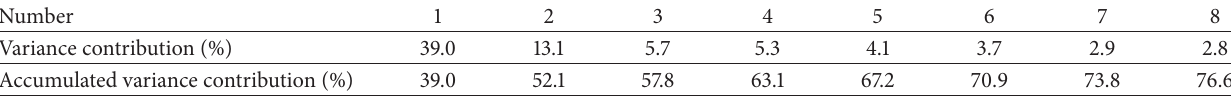
Table 1: Different EOF variance contributions of spring precipitation in South China.